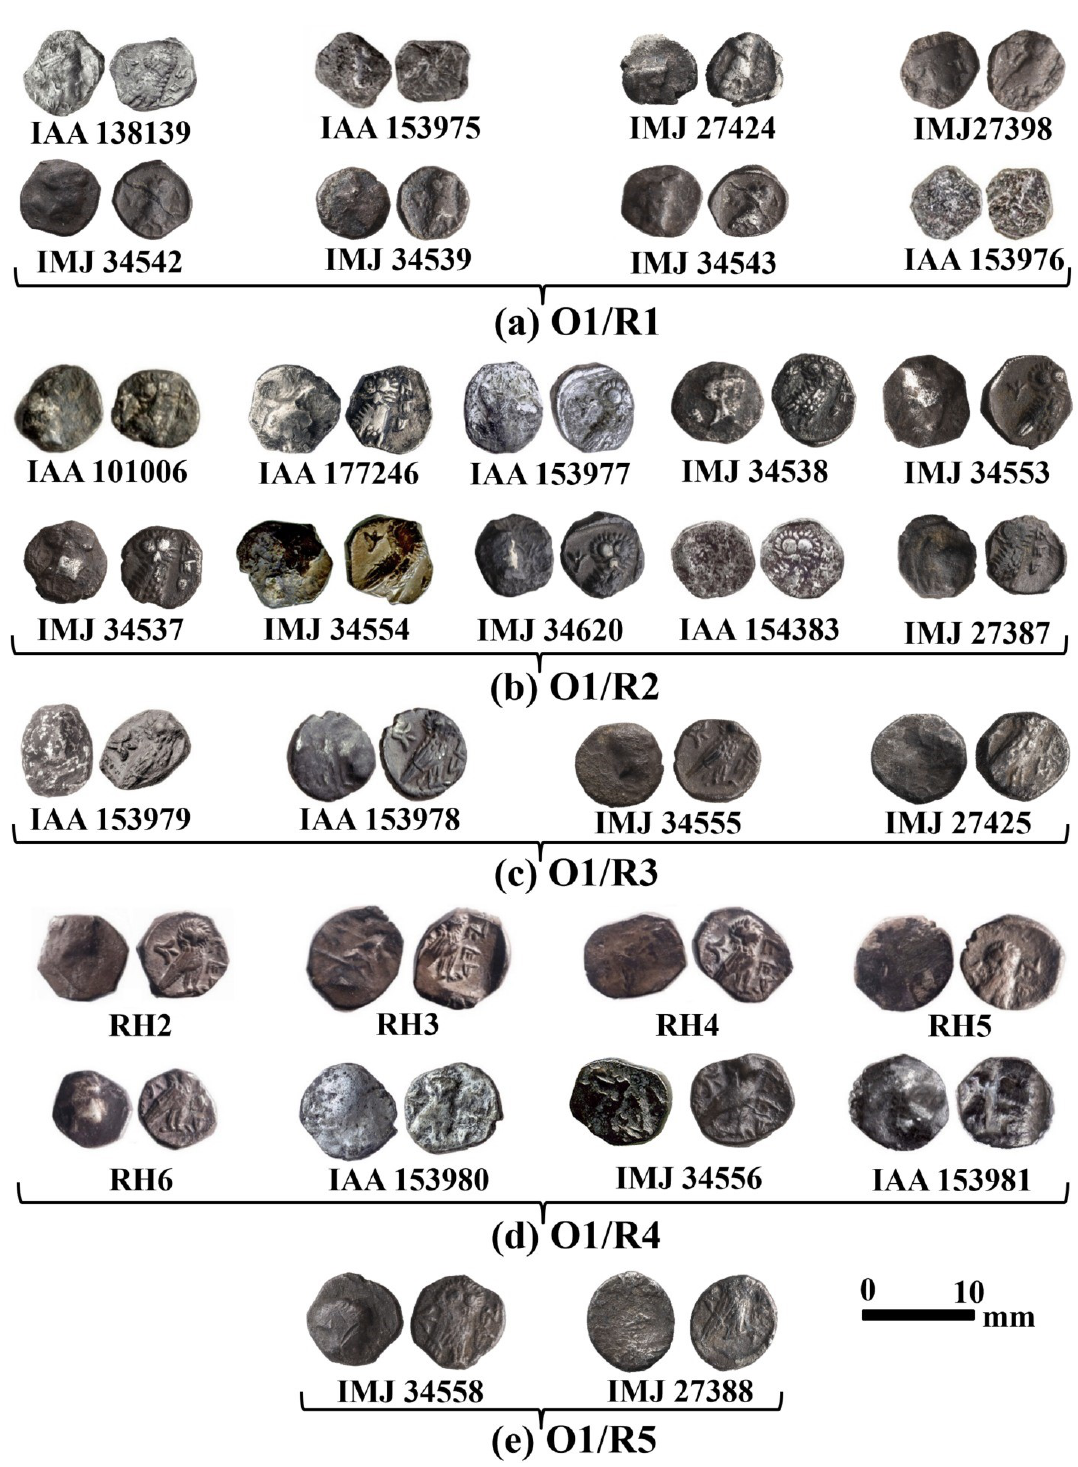
Figure 2. Yehud gerah coins — Type 5 of the Yehud series (Athena/Owl) corpus with die combinations O1 (obverse) and R1 (reverse), R2, R3, R4, and R5 (( a – e ), respectively) with the YHD legend.